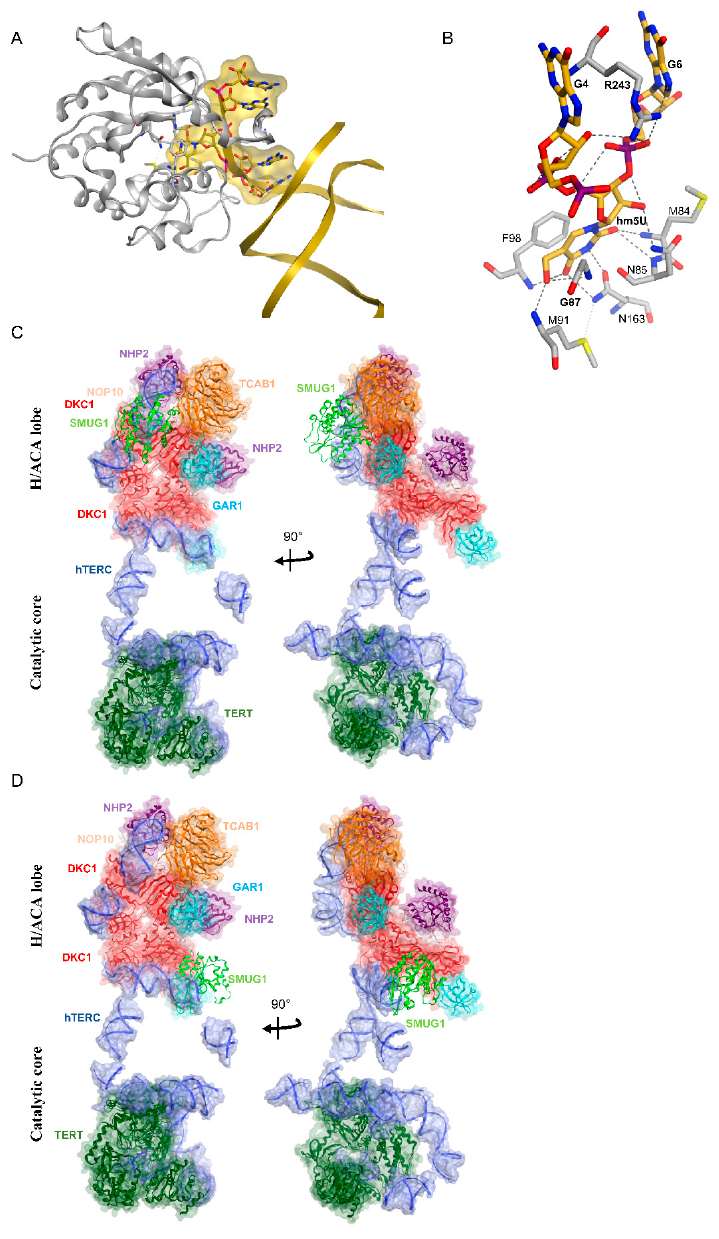
Figure 6. Computationally predicted binding pose of hSMUG1 to TERC and the human telomerase complex. ( A ) Homology model of hSMUG1 (shown in silver ribbons) bound to the fish TERC structure (shown in gold ribbons), which is computationally modified to mimic hTERC at the binding interface. The residues of hSMUG1 that interact with the flipped hm5U are shown in sticks with C atoms in silver. The flipped hm5U as well as the two nucleotides neighboring it on each side in TERC are depicted in sticks with C atoms in gold. Both for the residues and the nucleotides, N atoms are in blue, O atoms are in red, S atoms are in yellow, and P atoms are in magenta. The terminal 5 nucleotides of TERC are additionally highlighted depicting their molecular surface in gold. ( B ) Close-up view of panel A depicting the interaction of hSMUG1 active site with the flipped hm5U at position 220 and its neighboring nucleotides. Everything except the interacting residues is hidden to provide a clear view. The color code is the same as in panel A, except here P atoms are depicted in purple. Interactions are displayed as dotted lines. ( C , D ) Superimposing SMUG1 on the pdb structure of human telomerase complex cryo-EM. Our prior experimentally validated SMUG1–DKC1 complex structure is superimposed onto each of the two dyskerin (DKC1) units found in human telomerase. In both cases, a significant steric clash of SMUG1 with the rest of the human telomerase is